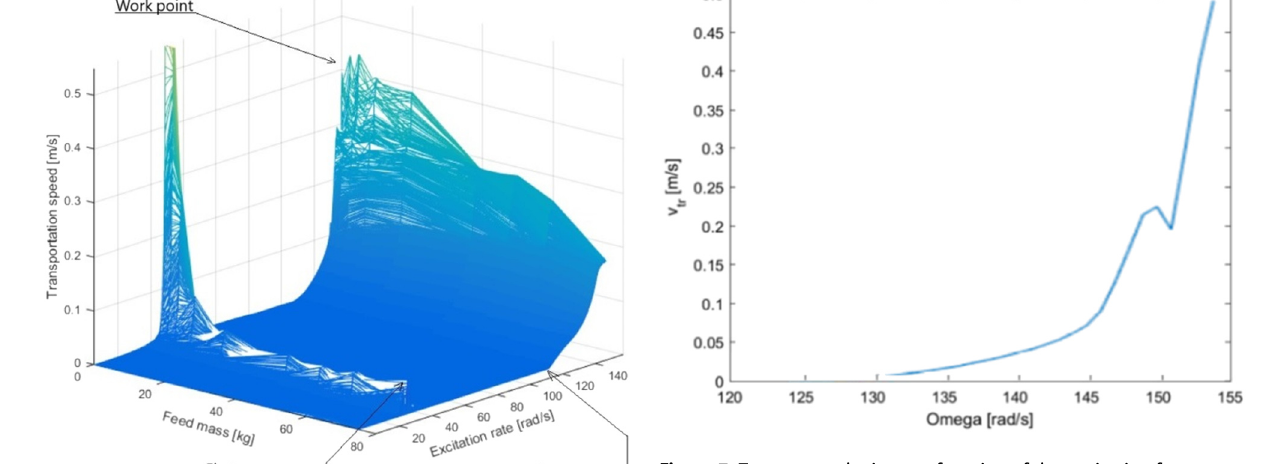
Figure 7: Transport velocity as a function of the excitation frequency, obtained by simulation for the working strategy behind the anti - resonance and at a small mass of the feed.